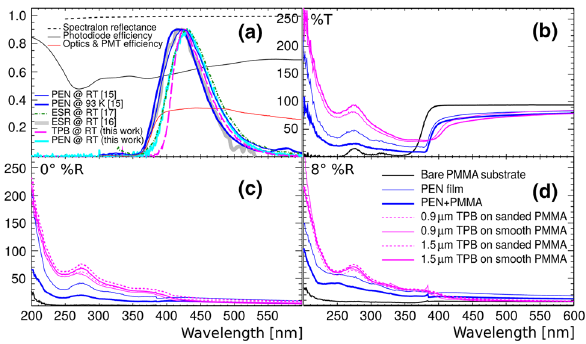
Fig. 1 a Emission spectra of PEN [15], ESR [16,17] and TPB normal- ized to the same amplitude. Also shown are the Spectralon hemispheri- cal reflectance, integrating sphere photodiode efficiency, and combined efficiency of optics and PMT in the VUV monochromator setup (see legend). Raw spectra of b transmittance (T-mode), c diffuse reflectance (R-mode with 0 ◦ sample holder) and d hemispherical reflectance (R- mode with 8 ◦ sample holder) of TPB, PEN and acrylic samples (see